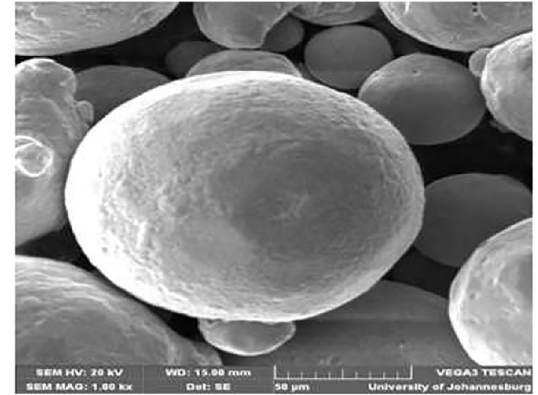
Figure 2. SEM morphology of Cu powder.